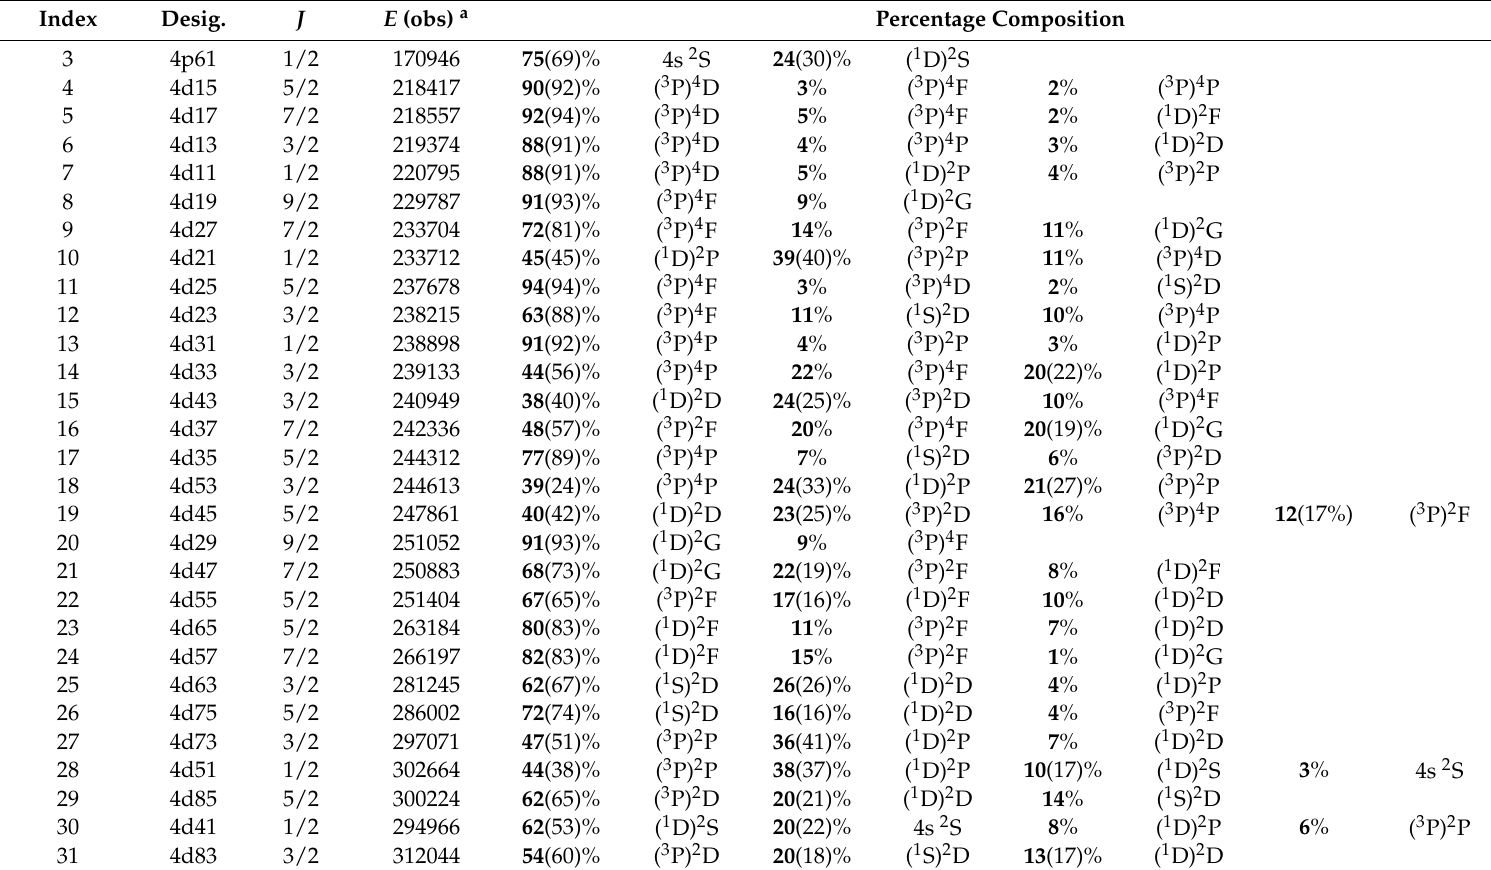
Table 10. Comparison of the present percentage compositions for the 4s4p 6 and 4s 2 4p 4 4d configurations of Y V (in bold type) with those of Singh et al. [17] (in parentheses). Level values are in cm − 1